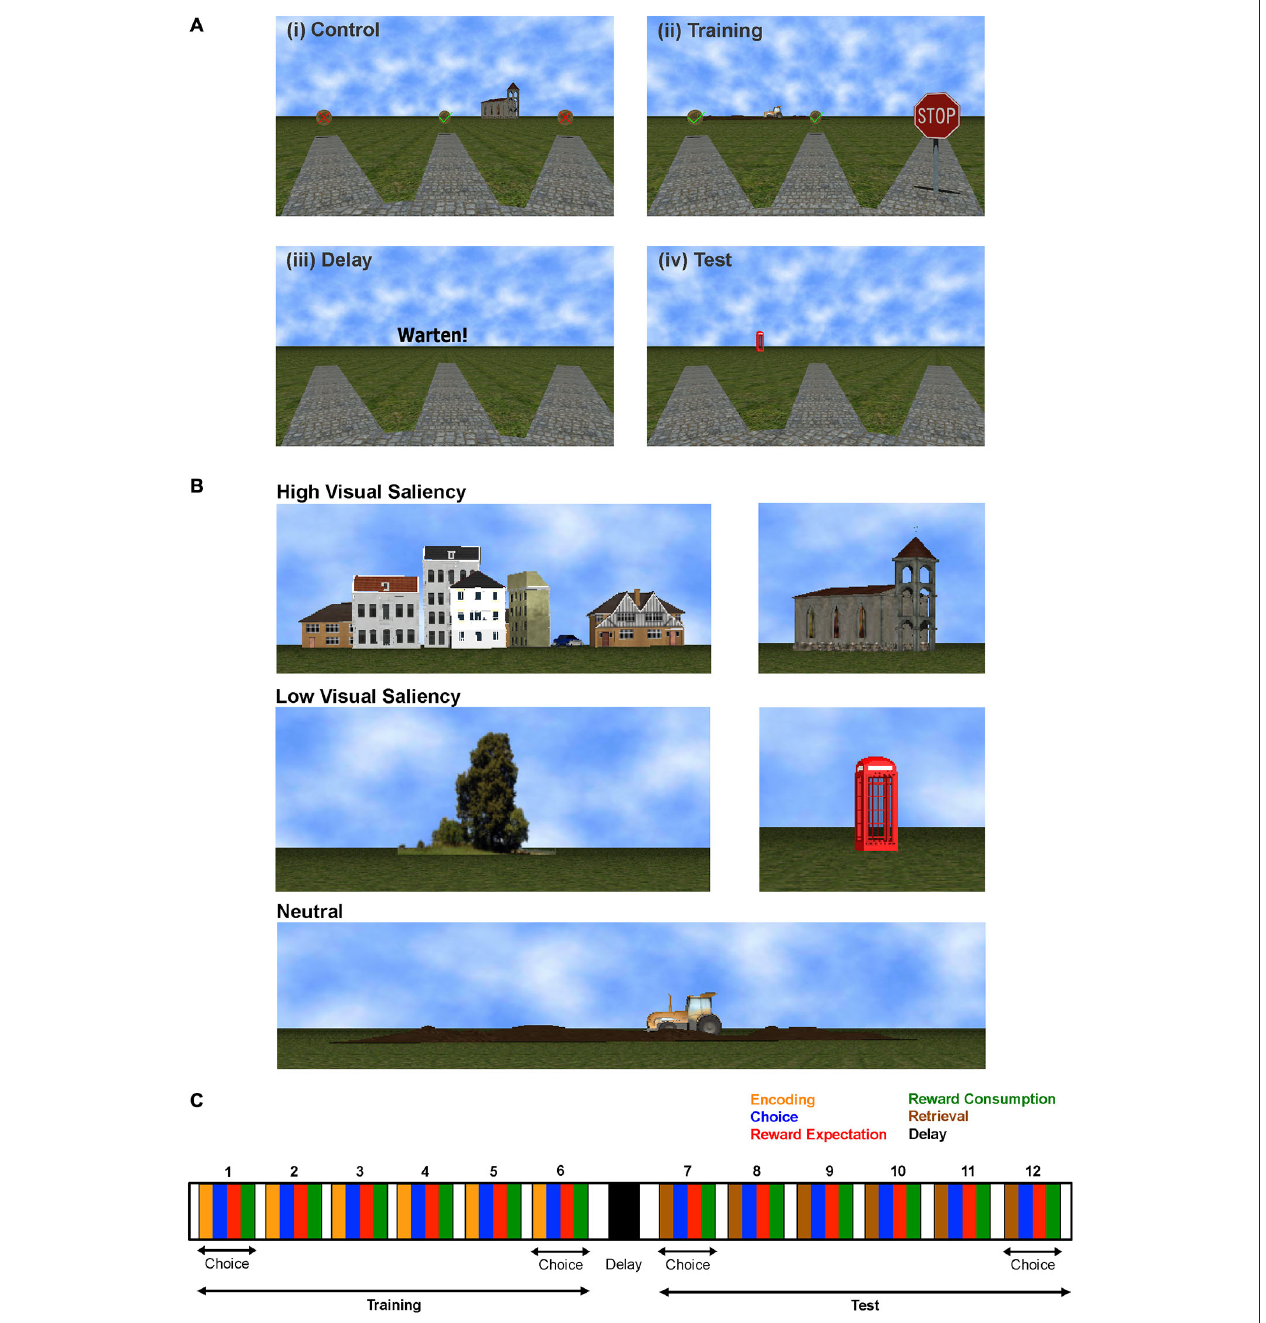
FIGURE 1 | Radial Arm Maze Task. (A) Task Stages: (i) Visuo-motor control phase, (ii) Training phase, (iii) Delay phase, and (iv) Test phase for each trial. (B) Landmarks of different visual saliency. (C) Experimenter defined task stages for one task trial consisting of training and test phases, each comprising six choices where the subject encodes (during training) or retrieves (during test) working memory information, chooses an arm, expects and (if correct) consumes the reward. Time on each task stage is completely self-paced.